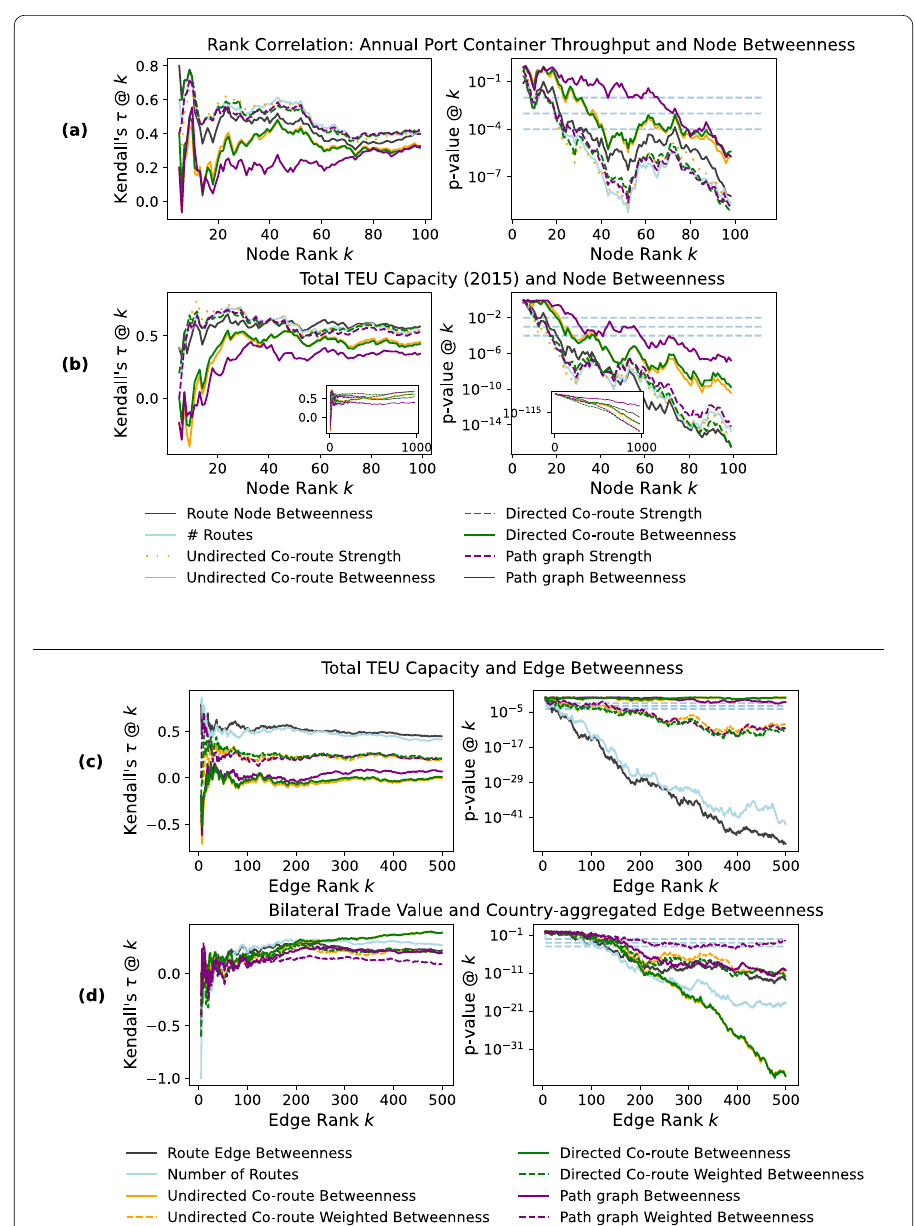
Figure 9 Rank correlations for port (a-b) and edge (c-d) importance measures. Ranking ports by number of routes they participates in has the strongest correlation with the top 100 ports by container throughput, and port rankings based on route betweenness correlate more strongly with ranking by container throughput than either topological betweenness measure. Ranking by route node betweenness correlates strongly with the top 100 ports by total TEU capacity. Correlation of edge rankings with route edge betweenness and total TEU capacity is strongly positive. Aggregating edge betweenness to the country level, betweenness in the directed and undirected co-route graphs correlates more strongly with bilateral trade than route edge betweenness or path graph betweenness. Dashed lines in the right plots indicate p = 0.01,0.001, and 0.0001